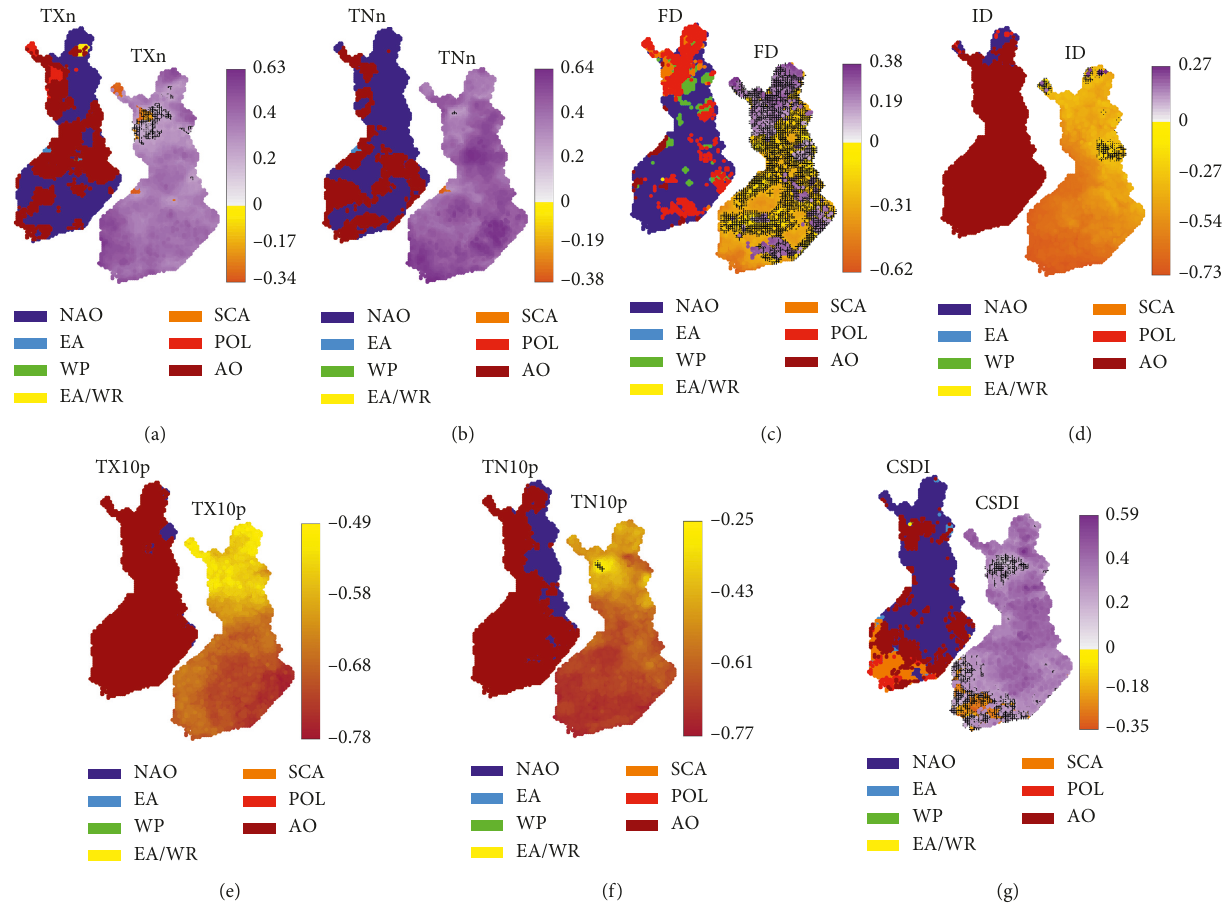
Figure 10: Spatial distribution maps of most influential NHTP (left) and its corresponding Spearman rank correlation (right) for cold temperature extreme indices including (a) TXn, (b) TNn, (c) FD, (d) ID, (e) TX10p, (f) TN10p, and (g) CSDI in Finland during 1961–2011. The stippling indicates areas where the correlations are statistically insignificant ( p >